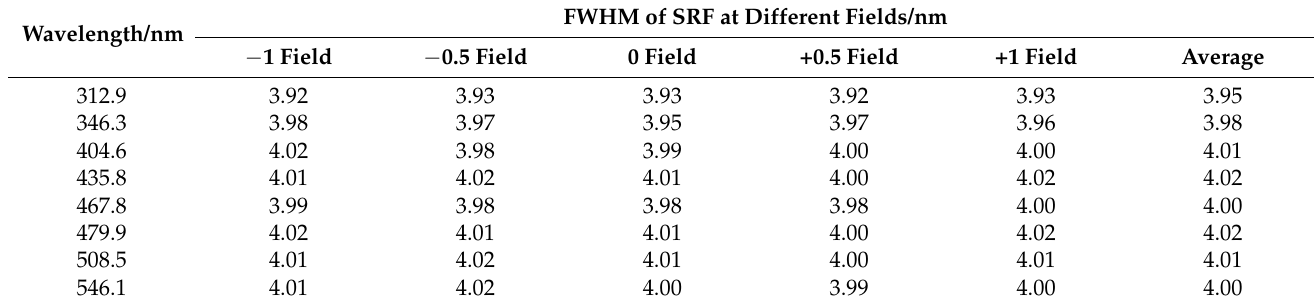
Figure 17. ( a , b ) Test device and ( c – e ) test results from the B1 spectrometer. ( c ) Spectral lines of the Hg–Cd lamp, ( d ) SRFs from the 479.9 nm spectral line; the SRF opt is fitted from raw data, and the SRF ins is the SRF after 6× pixels binning. ( e ) Scatter diagram of the 479.9 nm spectral line and its fitting curve. Table 5. Spectral resolution of B1 spectrometer with 6× pixels binning Wavelength/nm